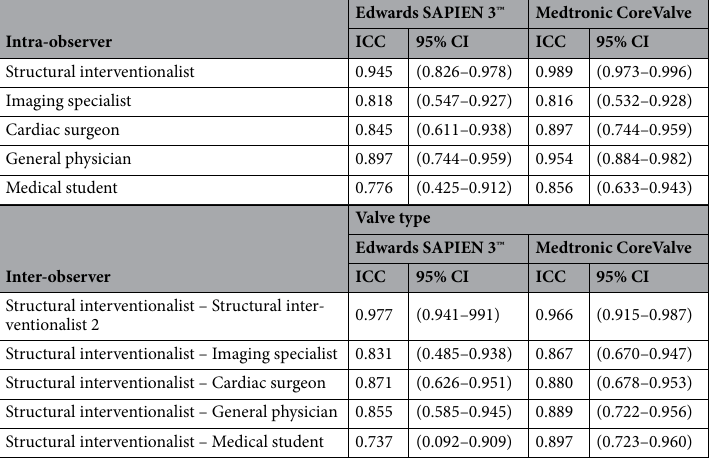
Table 7. Intra- and inter-observer ICC for valve selection. ICC: intraclass-correlation coefficient; CI: confidence interval.